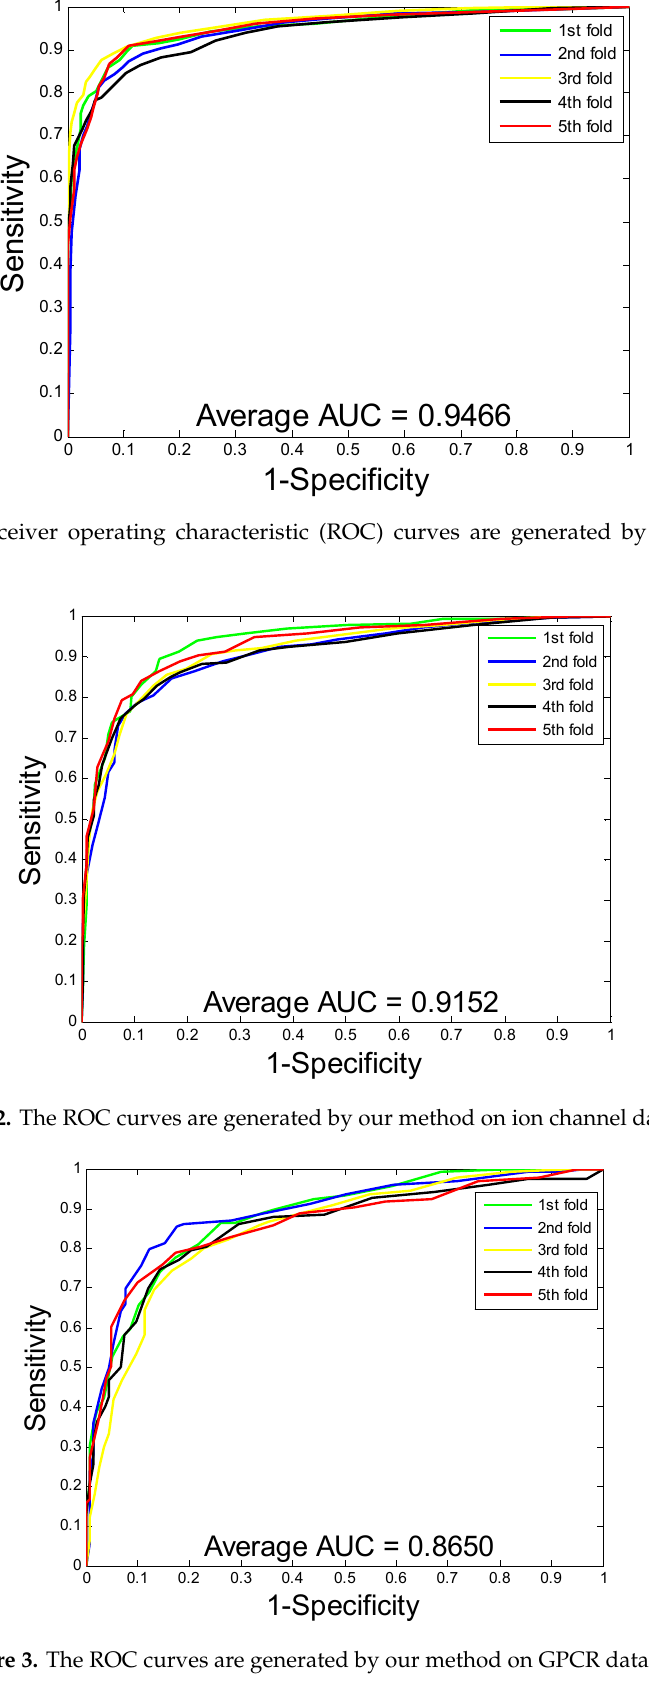
Figure 4. The ROC curves are generated by our method on nuclear receptor dataset. 2.3. Comparison with Support Vector Machine Classifier We combined the same feature extraction method with the popular support vector machine (SVM) classifier to predict the DTIs on the enzyme dataset to further assess the prediction results of the proposed method. Here, the five-fold cross-validation method is used in this experiment to compare the prediction performance of the SVM with that of the proposed model. The LIBSVM tool [21] is applied to perform classification for drug-target interaction prediction. At the same time, we also need to use the grid search method to optimize the relevant parameters of the SVM classifier in the experiment. Table 5 summarizes the predicted results of the RF and SVM classifiers on the enzyme dataset. As a result, the average values of accuracy, precision, sensitivity, and MCC were 85.20%, 85.73%, 84.45%, and 74.76%, respectively, with standard deviations of 0.82%, 0.99%, 1.64%, and 1.15%, respectively. Figure 5 shows the ROC curves that were generated on the enzyme dataset while using SVM. Comparing the prediction results of the two classifiers, we can see that, while using the same feature descriptor, the prediction performance that was yielded by the rotation forest classifier is significantly better than that yielded by the support vector machine classifier.